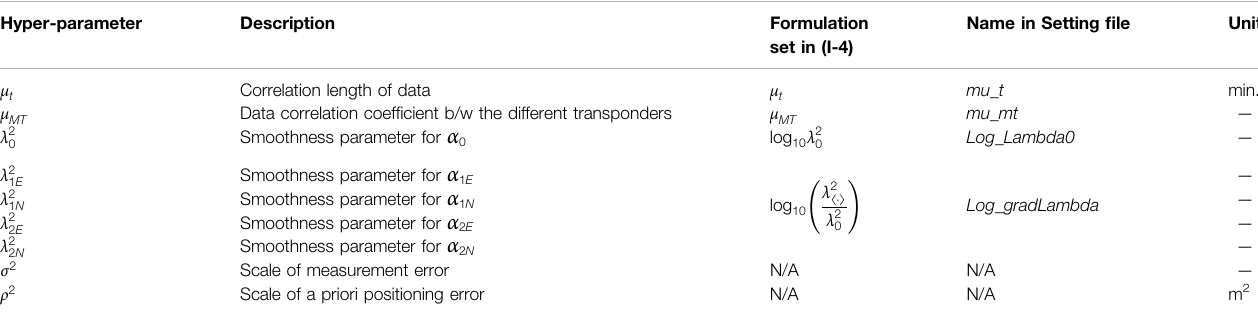
TABLE 2 | List of hyperparameter in GARPOS.